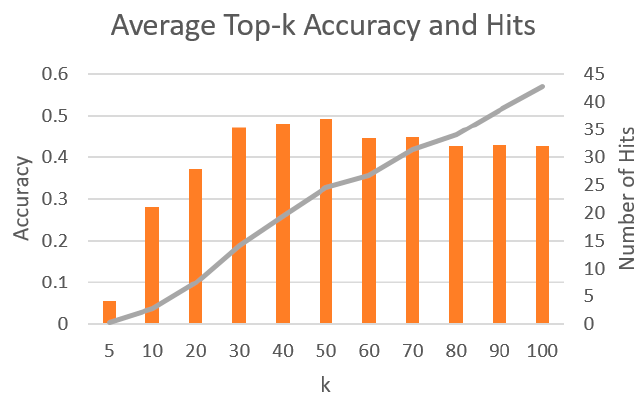
Figure 10. The average top-k accuracy and number of hits for different values of k.